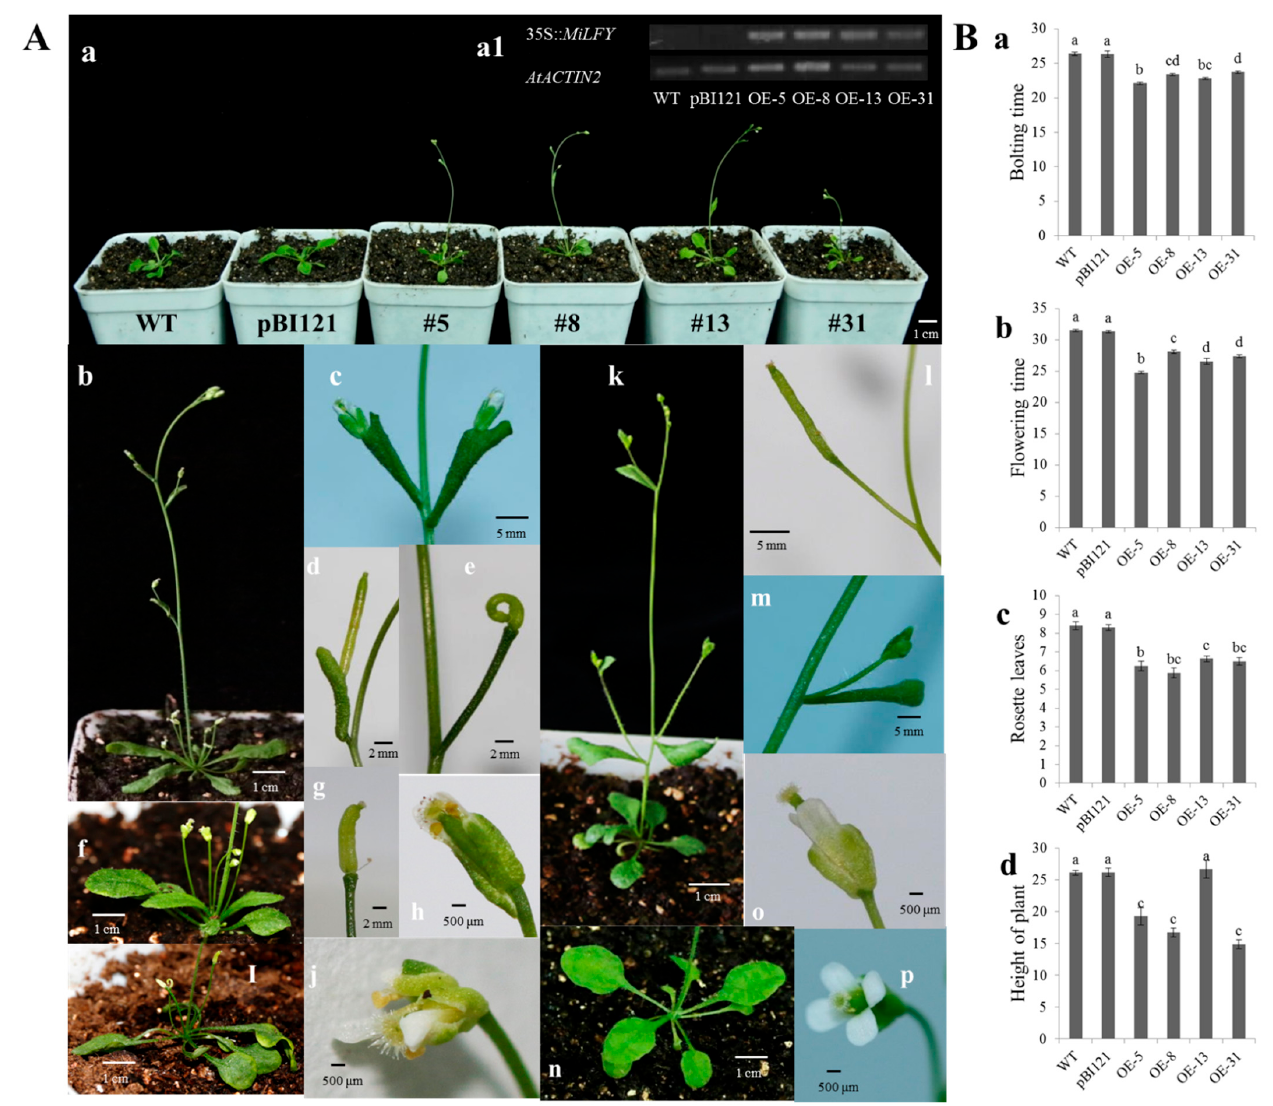
Figure 4. Phenotypic analysis of MiLFY-overexpressing transgenic plants. ( A ) ( a ) Phenotypes of MiLFY- overexpressing Arabidopsis , transgenic pBI121 empty vector Arabidopsis , and WT Arabidopsis at different flowering times. ( a1 ) A semiquantitative method was used to detect the expression of MiLFY in transgenic plants. AtActin2 was expressed in both transgenic and control plants, and the original electrophoretic results are shown in Supplement Figure S1. ( b – j ) Specific phenotypes of MiLFY-overexpressing Arabidopsis : ( b ) plant phenotype, ( c ) opposite or whorled stem branches and curly leaves, ( d ) siliques and curly leaves, ( e ) slightly curled siliques, ( f ) single flowering of basal branches, ( g , i ) small and short siliques, and ( h , j ) flowers with few petals. ( k – p ) Normal phenotypes of WT Arabidopsis : ( k ) plant phenotype, ( l ) siliques, ( m ) stem branches, ( o , p ) flowers, and ( n ) basal branches. ( B ) ( a ) Comparison of bolting time between MiLFY transgenic plants and the control lines. Bolting time was measured when the plant was bolting until the height was approximately 1 cm. ( b ) Comparison of flowering time between MiLFY transgenic plants and the control lines. The flowering time was measured when the first flower opened. ( c ) Comparison of the number of rosette leaves between MiLFY transgenic plants and the control lines. The number of rosette leaves was determined when the plants were bolting. ( d ) Comparison of plant height between MiLFY transgenic plants and the control lines. The height of the plants was measured 15 d after flowering. Significant differences among the samples were assessed at the p < 0.01 level by Student’s t tests; different letters indicate significantly between different